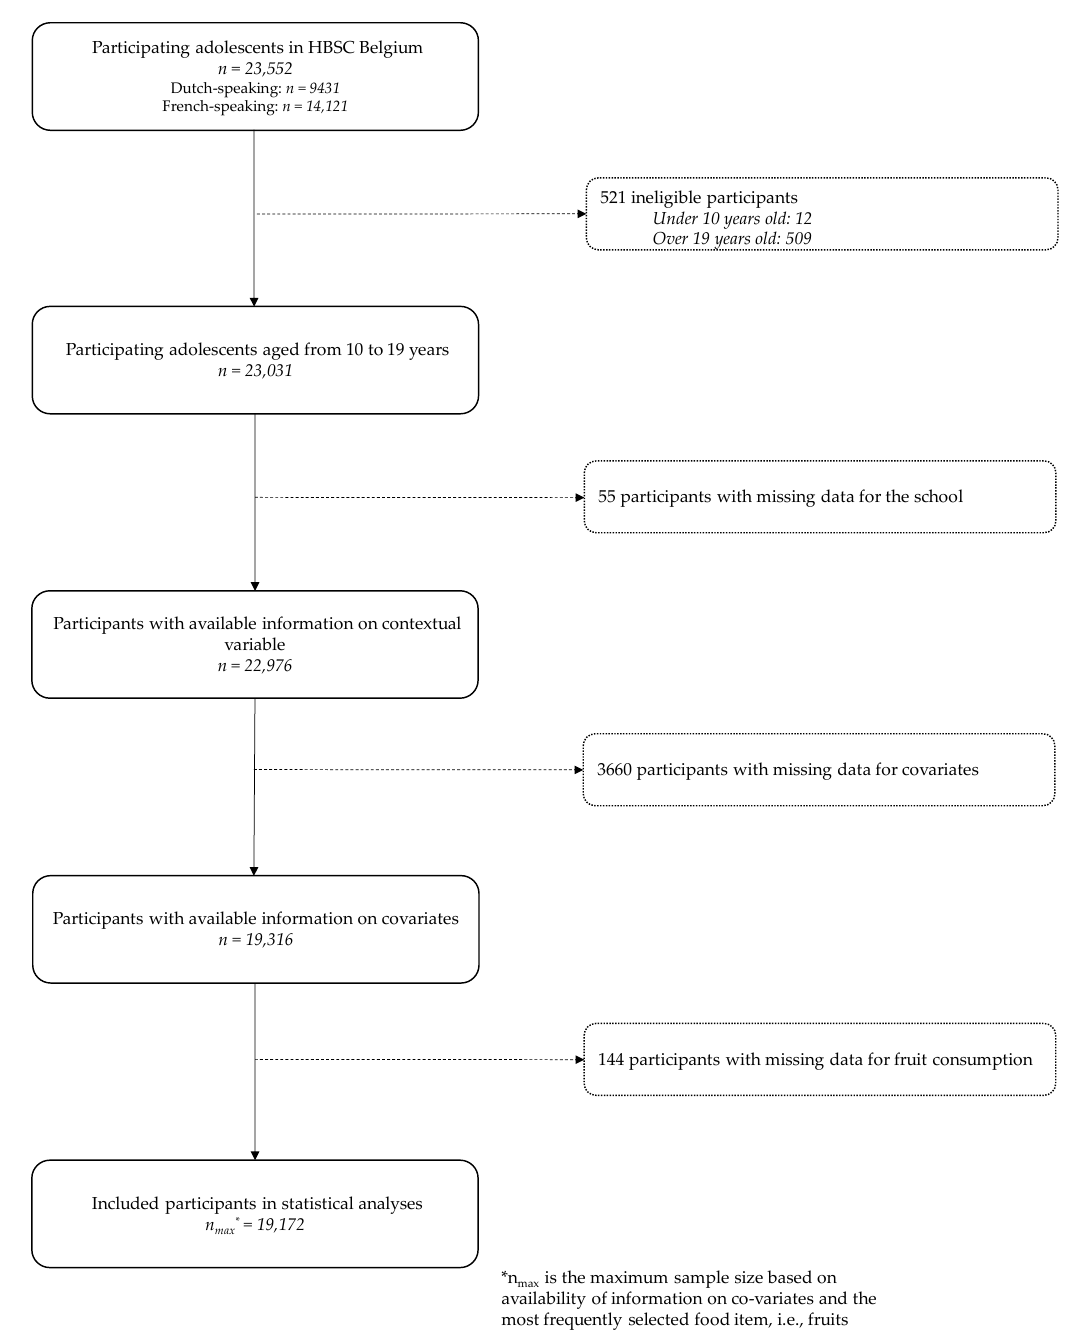
Figure 1. Inclusion diagram of adolescents in Belgium, “Health Behavior in School-Aged Children” (HBSC), 2014.